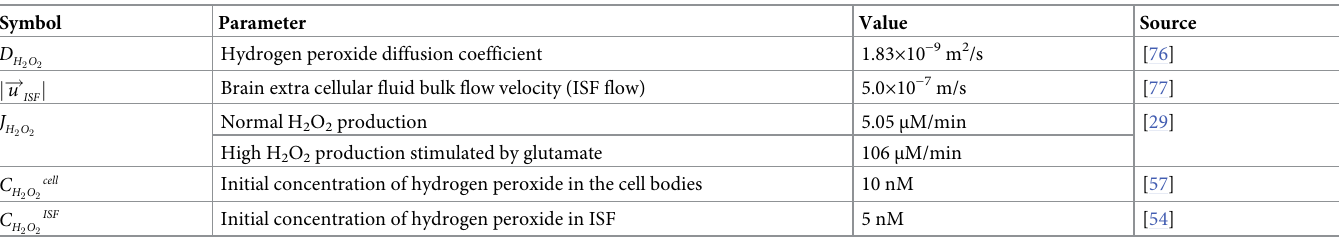
The diffusion coefficient for H 2 O 2 is used in (11) as a constant parameter describing isotropic symmetric diffusion. The velocity of ISF flow is represented as a mean module value. The direction of the vector is indicated in Fig